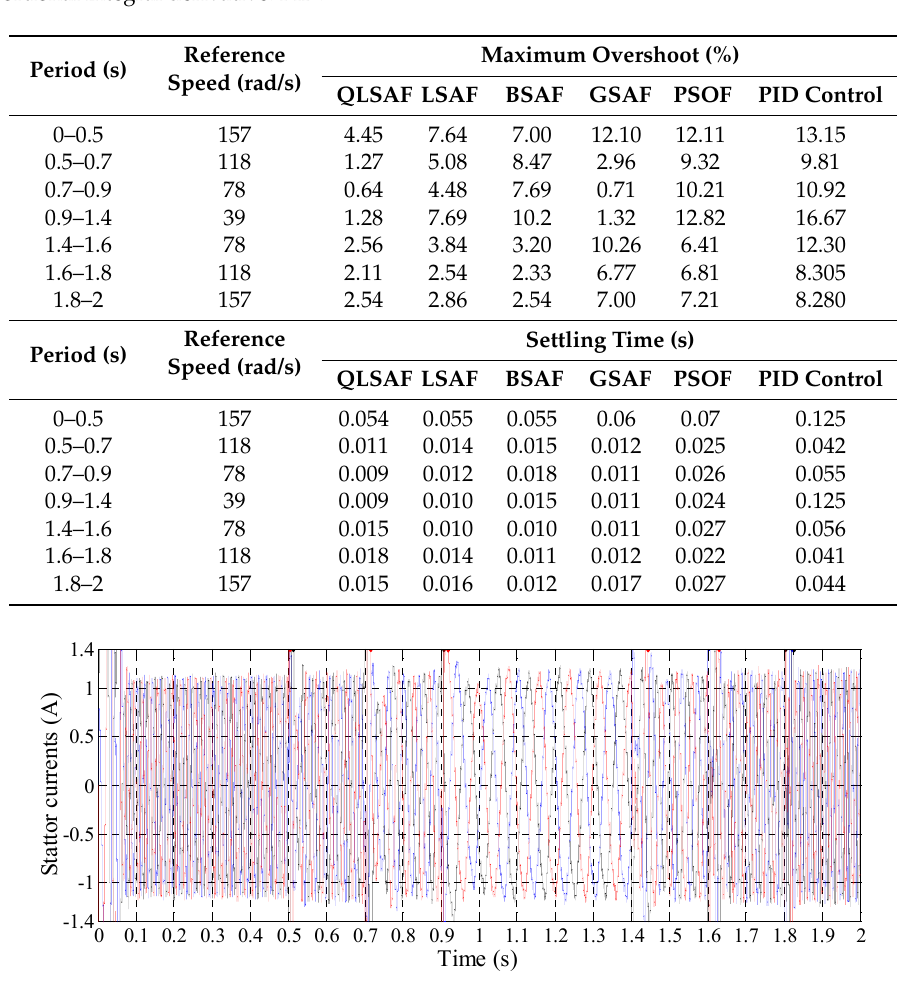
Figure 19. Stator currents with the change in the reference speed.